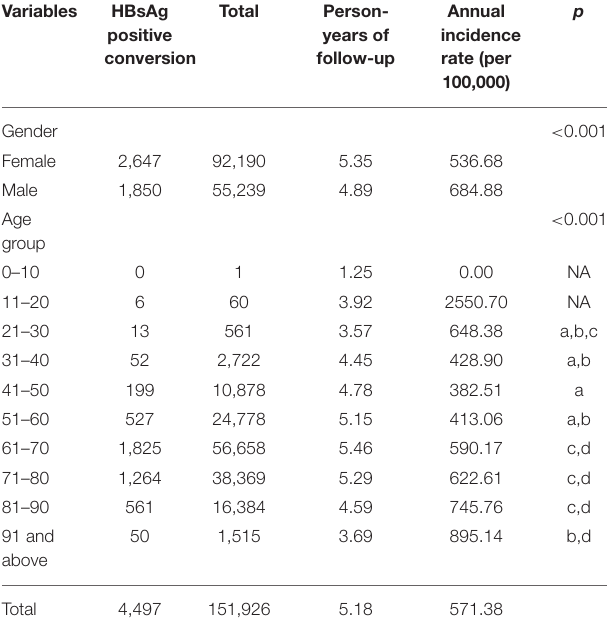
TABLE 1 | Demographic characteristics of the 151,926 participants who were HBsAg negative at baseline and who experienced HBsAg positive conversion.